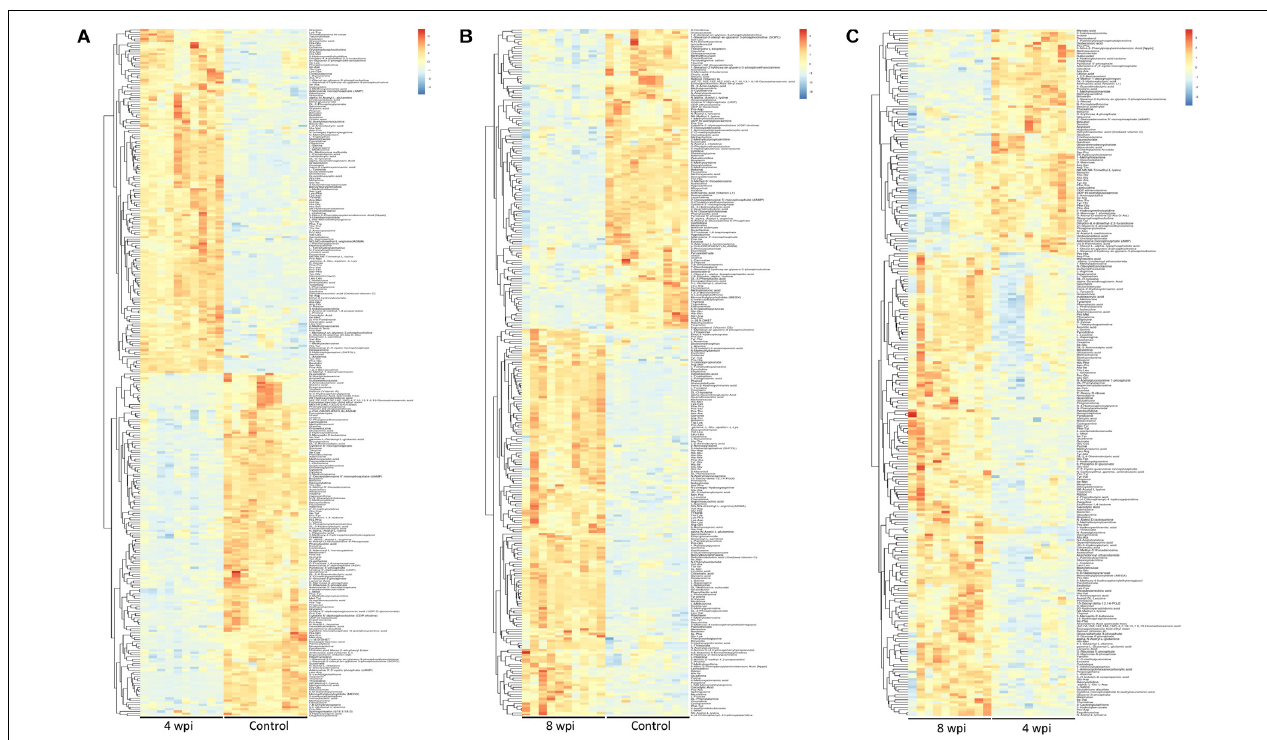
FIGURE 4 | Heatmaps representation of the differential metabolites identified between different infection group vs control group in ESI+ mode. (A) 4 wpi vs control; (B) 8 wpi vs control; (C) 8 vs 4 wpi. The color blocks at different positions represent the relative expression of metabolites at corresponding positions, red represents up-regulated, and blue represents down-regulated.